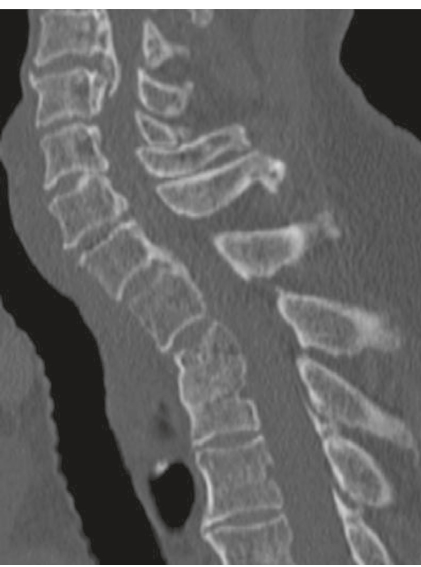
Figure 4: Sagittal CTof the cervicothoracic spine six months after operation shows bony fusion at